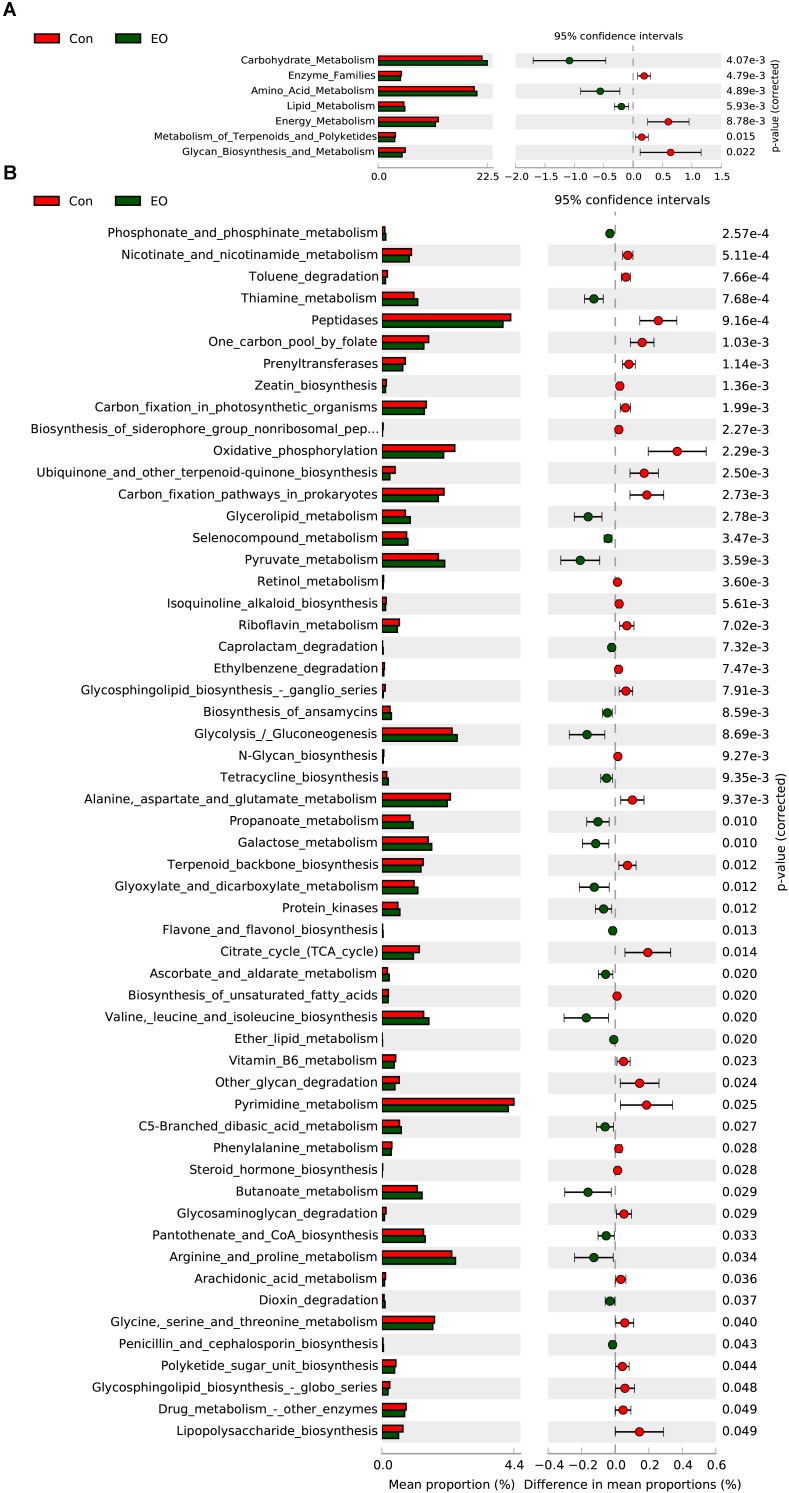
Microbial function prediction in the colon of weaned piglets fed with or without dietary EO. The second level (A) and third level (B) of KEGG pathway were showed in the extended error bar. The P -values were shown at right. Con: the basal diet; EO: the basal diet supplemented with essential oils.